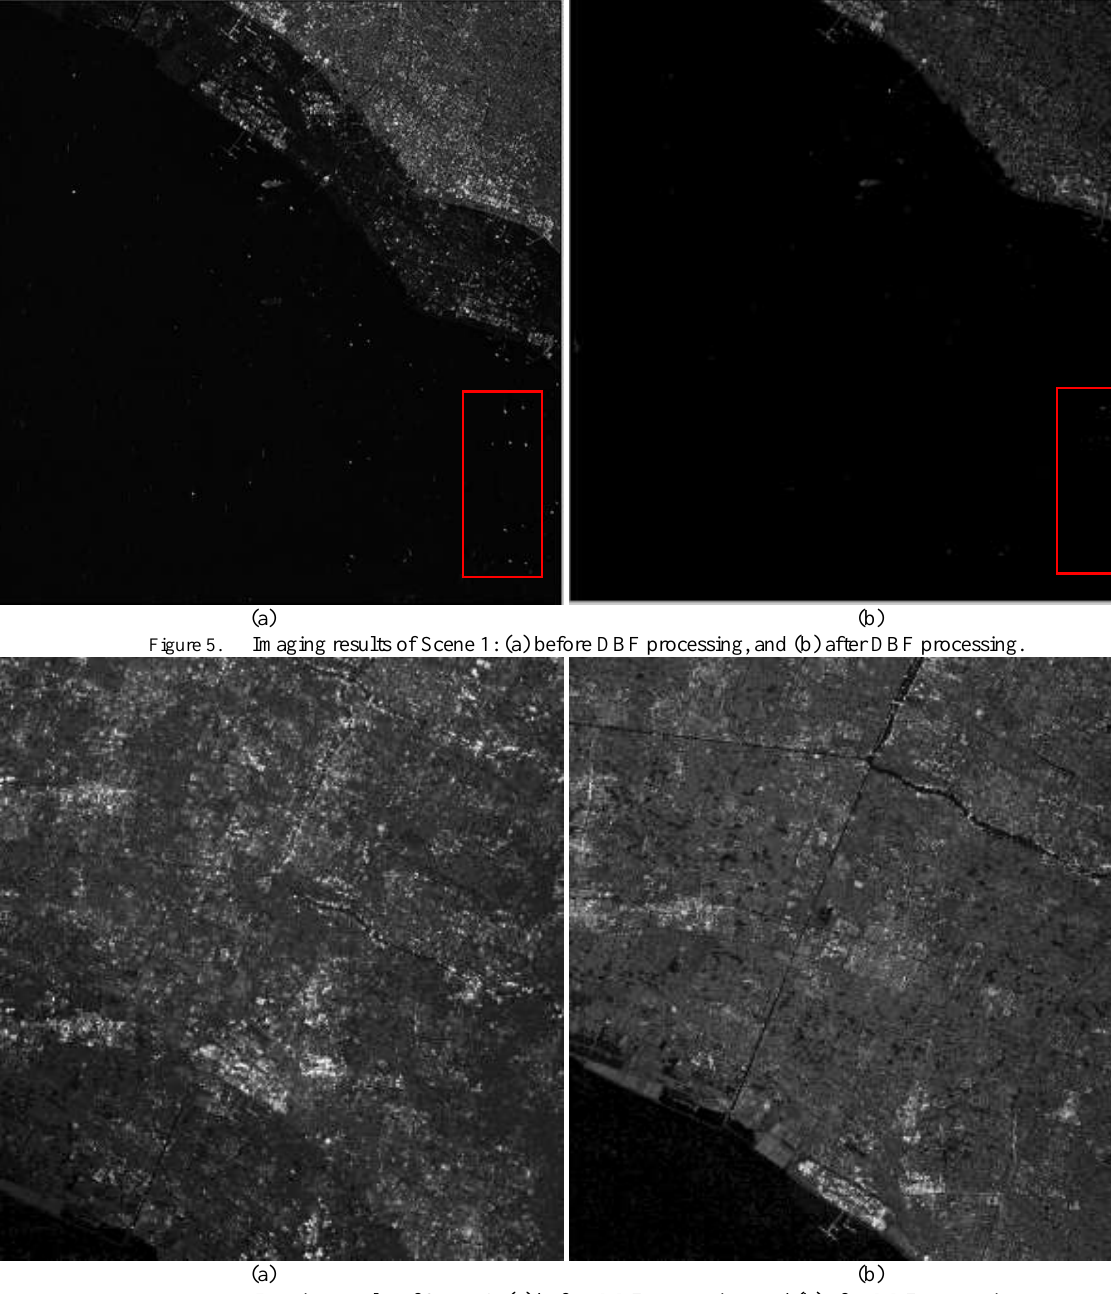
Figure 6. Imaging results of Scene 2: (a) before DBF processing, and (b) after DBF